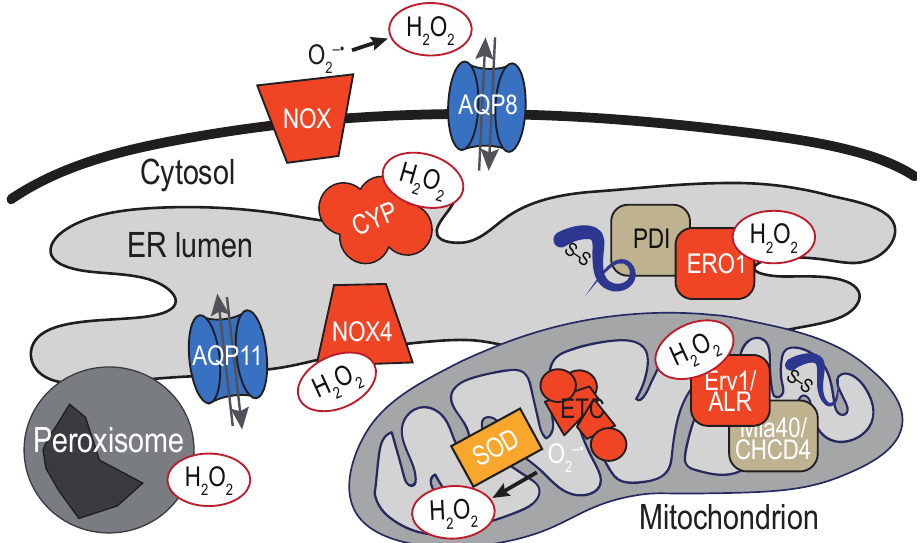
Figure 3. Sources of H 2 O 2 at the endoplasmic reticulum (ER). Several direct and indirect enzymatic sources of H 2 O 2 are depicted and colored in dark orange (refer to text for more details). Two examples of peroxiporins that facilitate bi-directional peroxide transport across membranes are noted in blue.